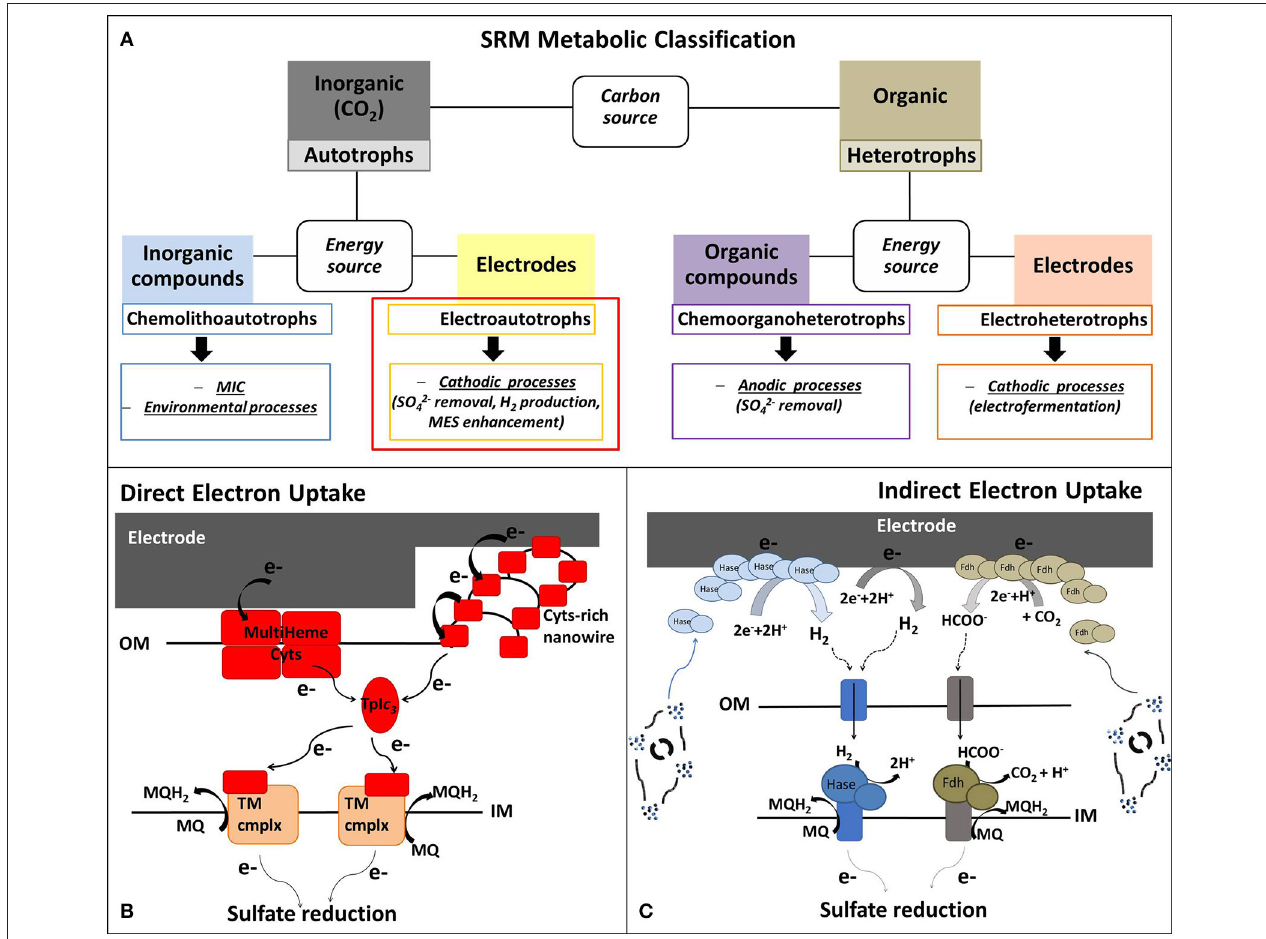
FIGURE 1 | (A) Metabolic classification of the sulfate-reducing microorganisms (SRM) presented in this Mini-Review, whereby the review focus is on electroautotrophic SRM. (B , C) Schematic model of possible extracellular electron uptake (EEU) mechanisms in electroautotrophic SRM with (B) Direct EEU: the cathodic electrons can enter SRM cells through outer membrane (OM) multiheme cytochromes (Cyts) or via Cyt-covered nanowires (Deng et al., 2018). Cyt-rich group of SRM (Deltaproteobacteria and Nitrospirae) are characterized by periplasmatic tetraheme Type I cytochrome c3 (TpI c3 ) that could act as periplasmatic electron shuttle component, like cytochrome Cyc-1 in A. ferroxidans ( Ishii et al., 2015) and the monoheme c -Cyt PccH in Geobacter sulfurreducens (Strycharz et al., 2011). TpI c3 serves then as electron donor for several inner membrane redox complexes that reduce the menaquinone pool or are involved in transmembrane electron transfer; and (C) Indirect EEU: SRM belonging to Cyt-poor group (Archaea and Clostridia) have no periplasmatic multiheme c -Cyts and they most probably perform a mediated electron transfer, using H 2 and formate as soluble electron donors for their hydrogenases (Hase) and formate dehydrogenases (Fdh) associated to the inner membrane (IM). The abiotic electrochemical production of H 2 and formate can be enhanced by extracellular Hase and Fdh, excreted by viable cells or released after microbial death (Deutzmann et al., 2015). MES, Microbial electrosynthesis; MIC, microbial induced corrosion; MQ/MQH 2 , menaquinone/menaquinol; TM cmplx, transmembrane